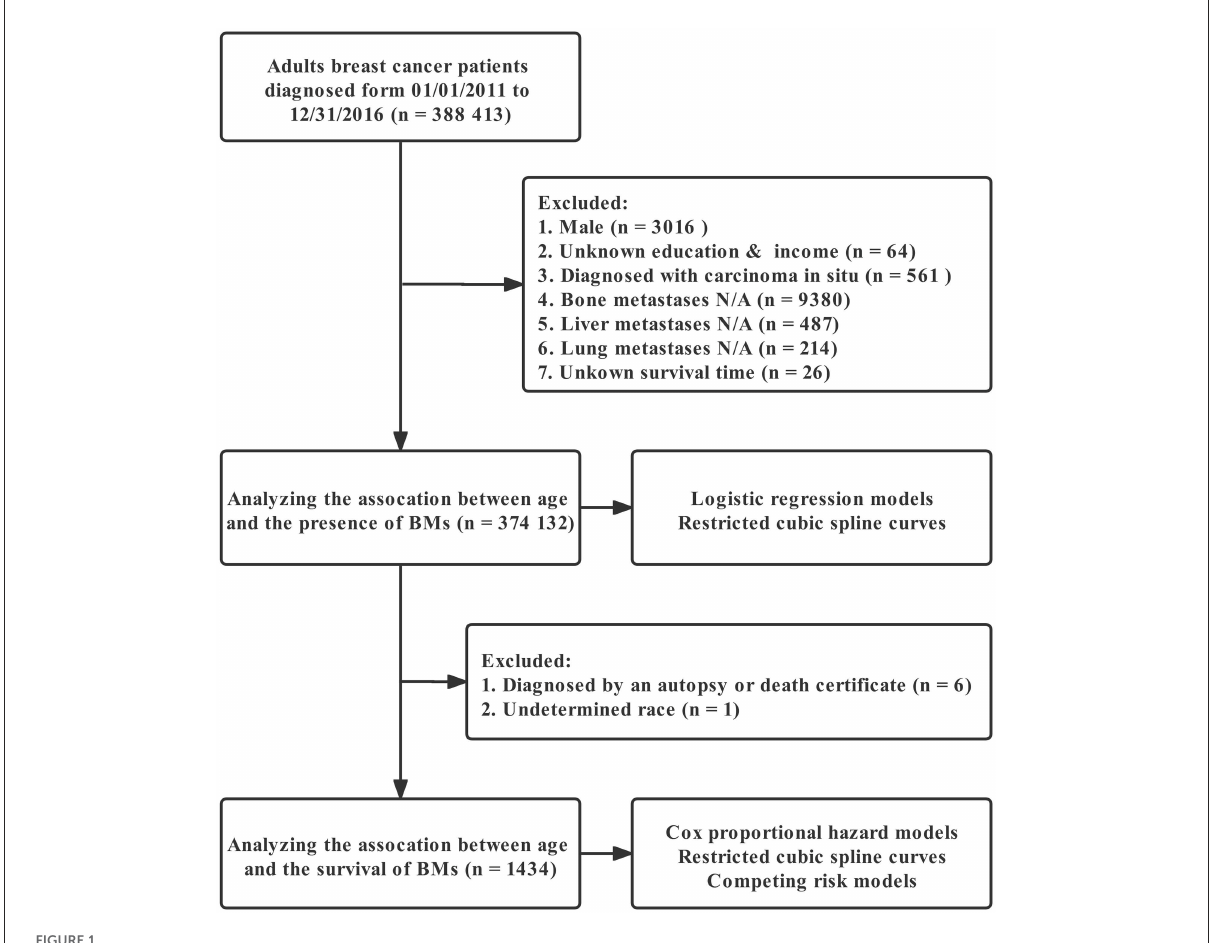
FIGURE1 Analytical workflow.